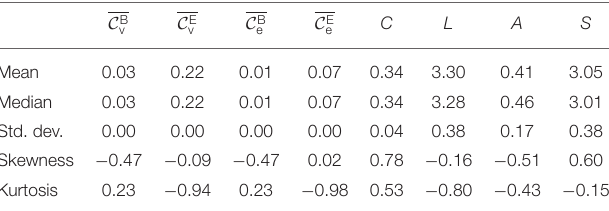
TABLE 1 | Descriptive statistic of local (spatially averaged betweenness centralities ( C B v and C B e ) and eigenvector centralities ( C E v and C E e ) and global network characteristics (global clustering coefficient C , average shortest path length L , assortativity A , and synchronizability S ), from phase B1 for the N s = 23 subjects with a taVNS-induced immediate effect and a short-/long-lasting enduring effect. For Gaussian distributed data, skewness and (excess)